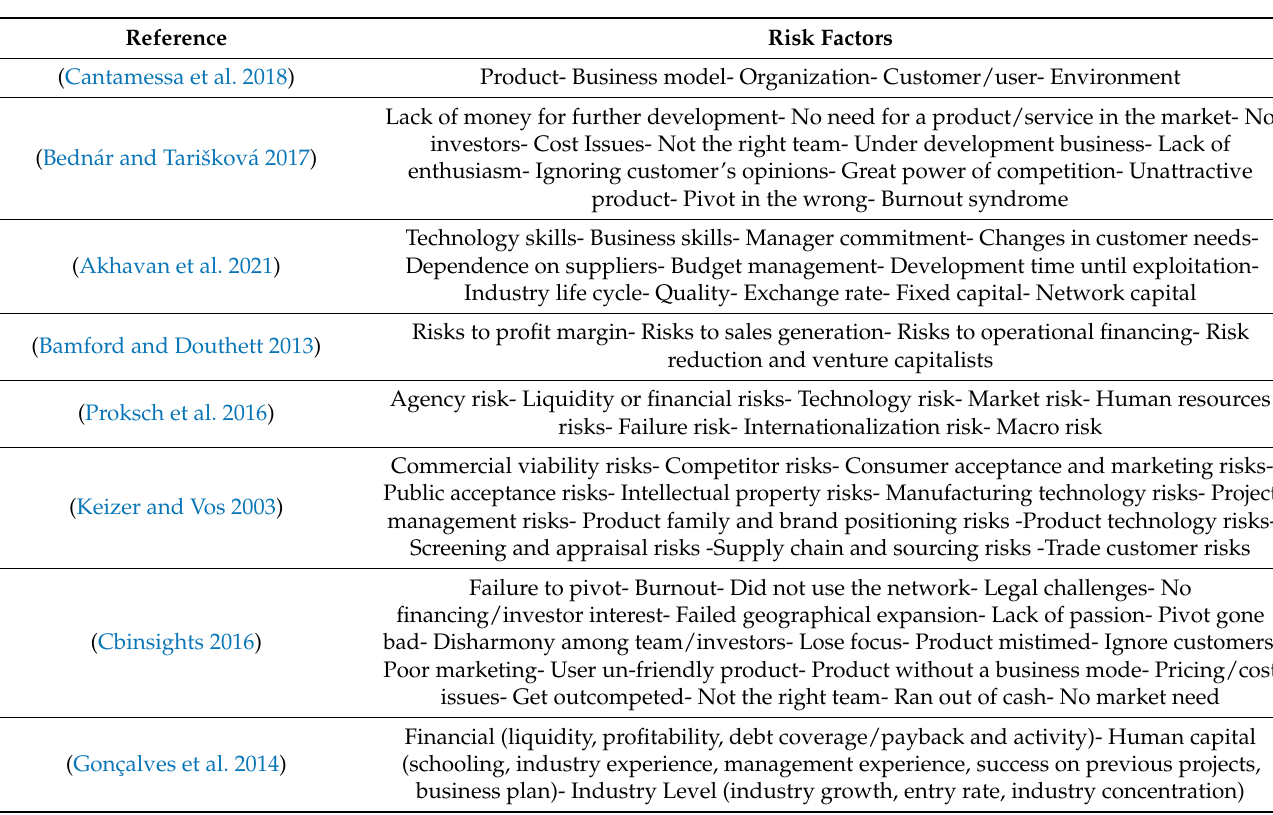
Table 1. Causes of start-up failure.